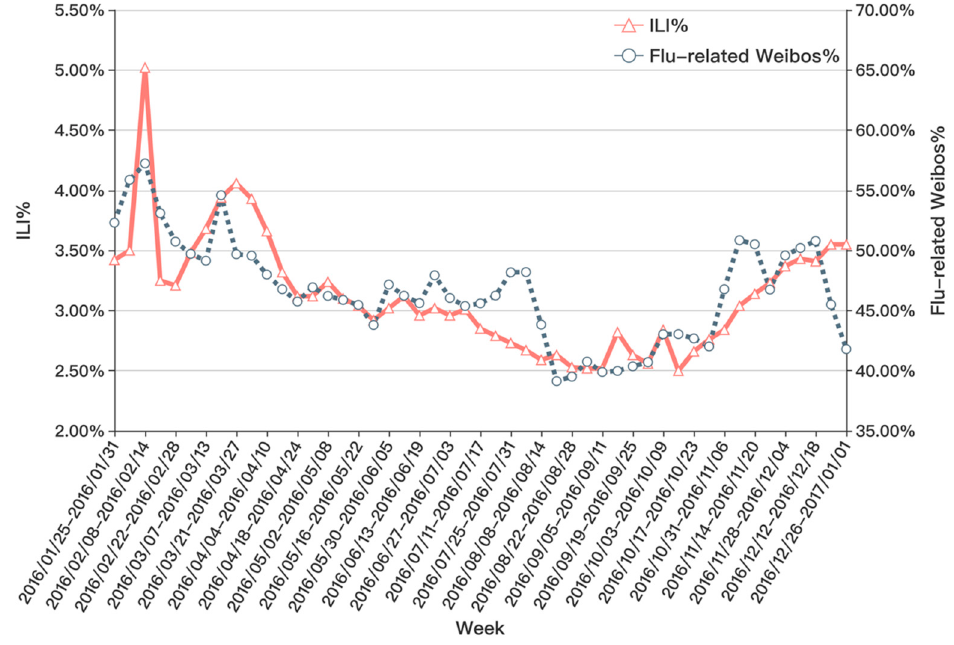
Figure 15. Trend Comparison of Flu-related Weibos% and influenza-like illness (ILI)%.